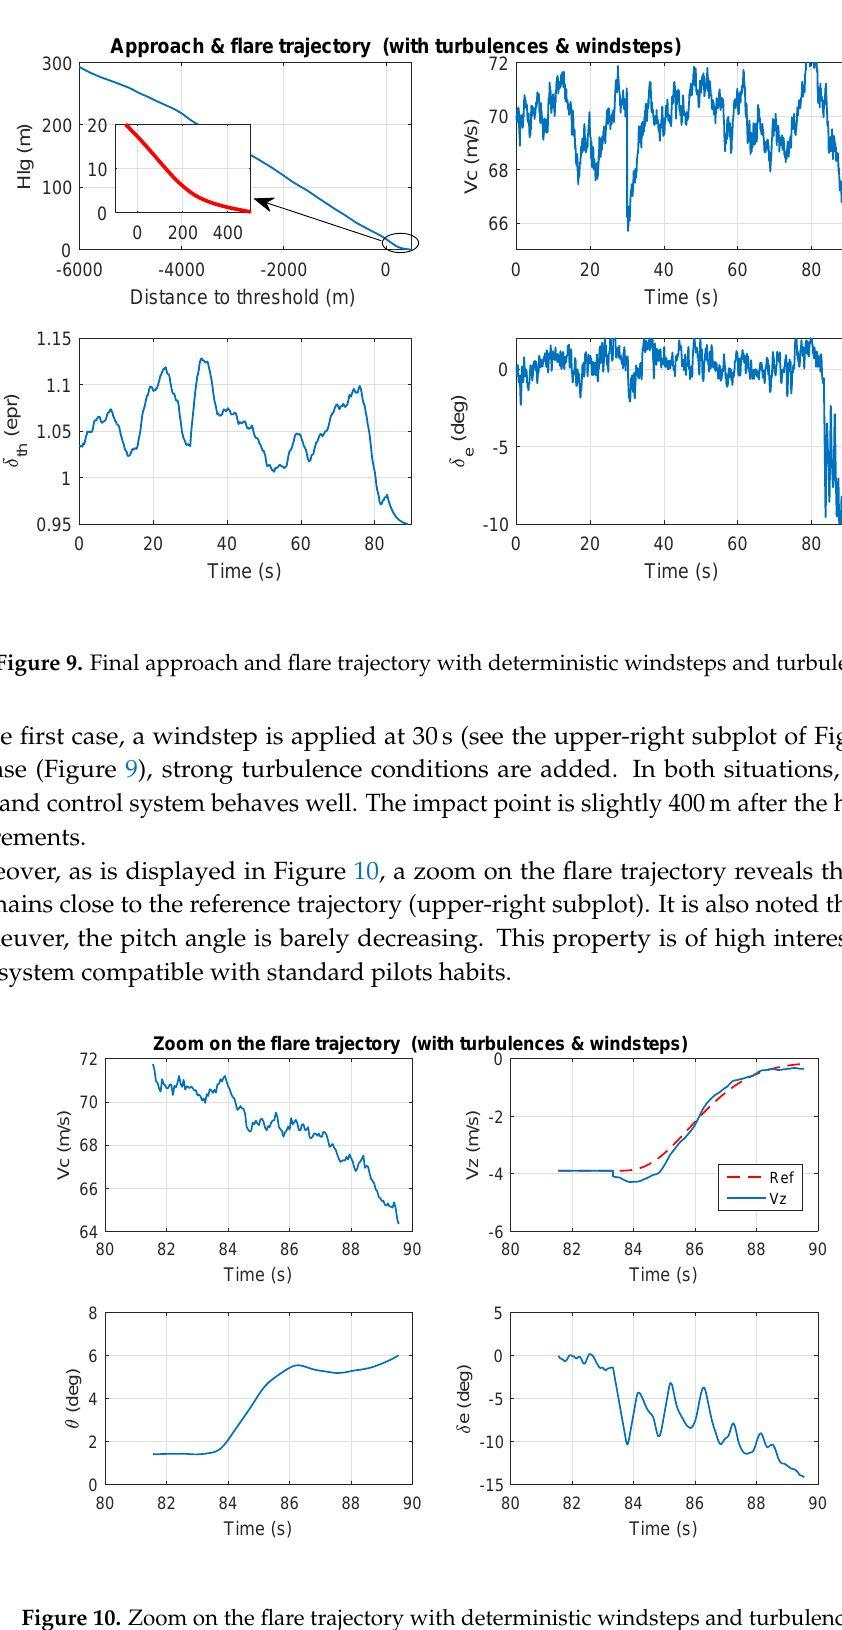
Figure 10. Zoom on the flare trajectory with deterministic windsteps and